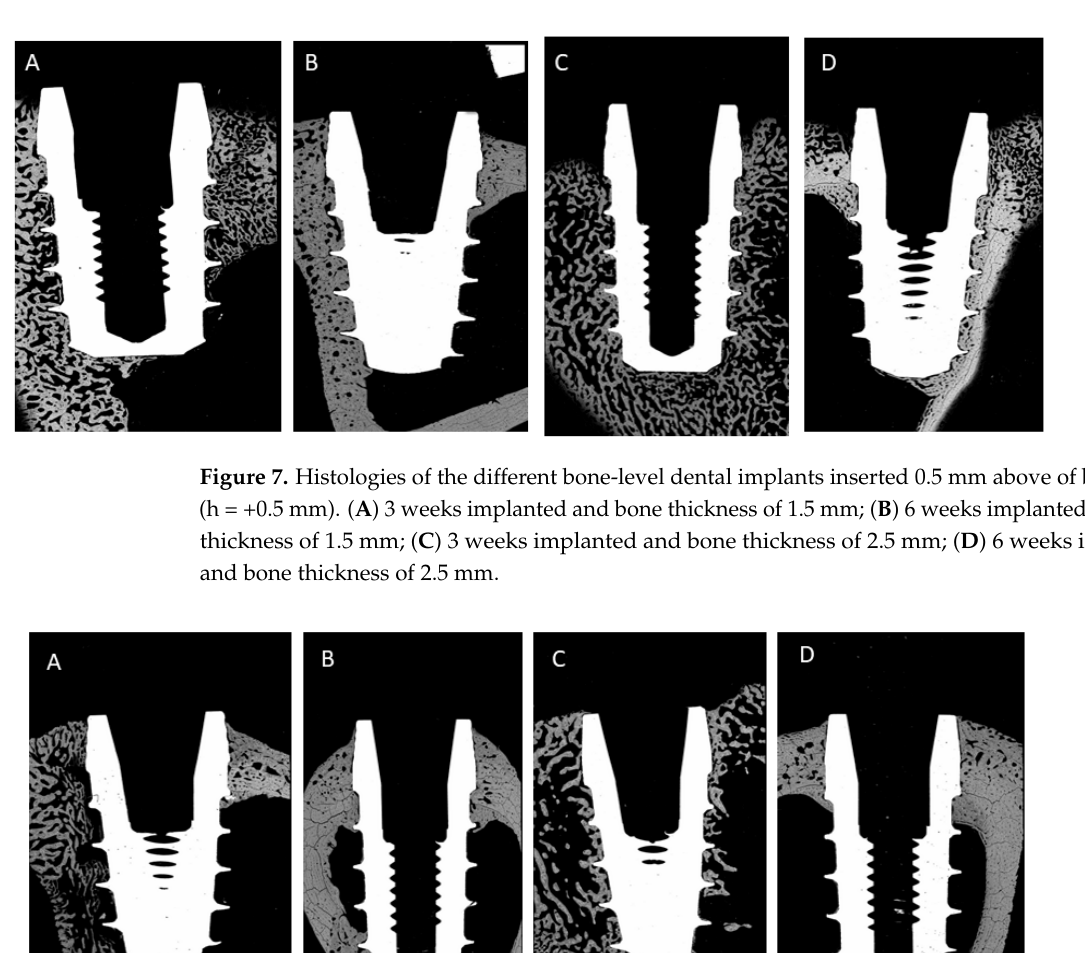
Figure 9. Histologies of the different bone-level dental implants inserted at 0.5 below the bone level (h= −0.5 mm). ( A ) 3 weeks implanted and bone thickness of 1.5 mm; ( B ) 6 weeks implanted and bone thickness of 1.5 mm; ( C ) 3 weeks implanted and bone thickness of 2.5 mm; ( D ) 6 weeks implanted and bone thickness of 2.5 mm.